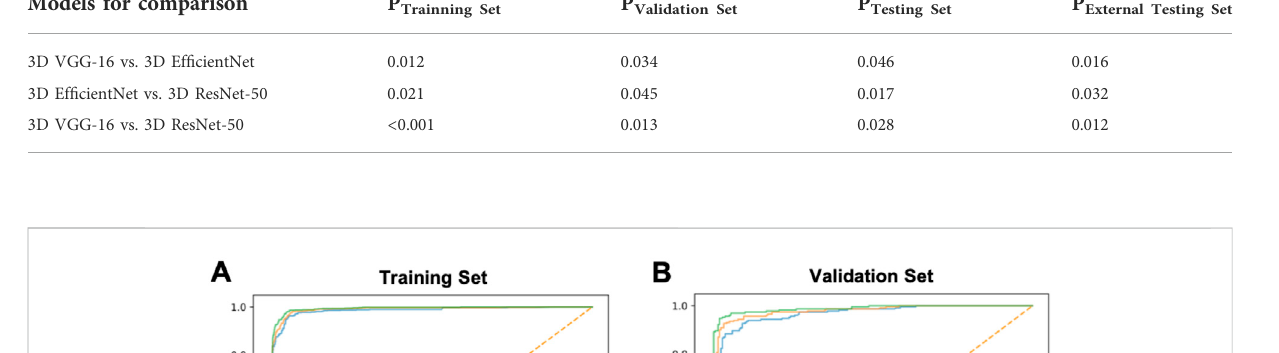
performance for 3D ResNet-50 was the highest in the training set, validation set and testing set. 3D ResNet-50 model achieved an AUC of 0.961 and an accuracy of 0.971 in the testing set, outperforming the other two models (3D ResNet-50 AUC vs. 3D VGG-16 AUC: 0.961 vs. 0.908,